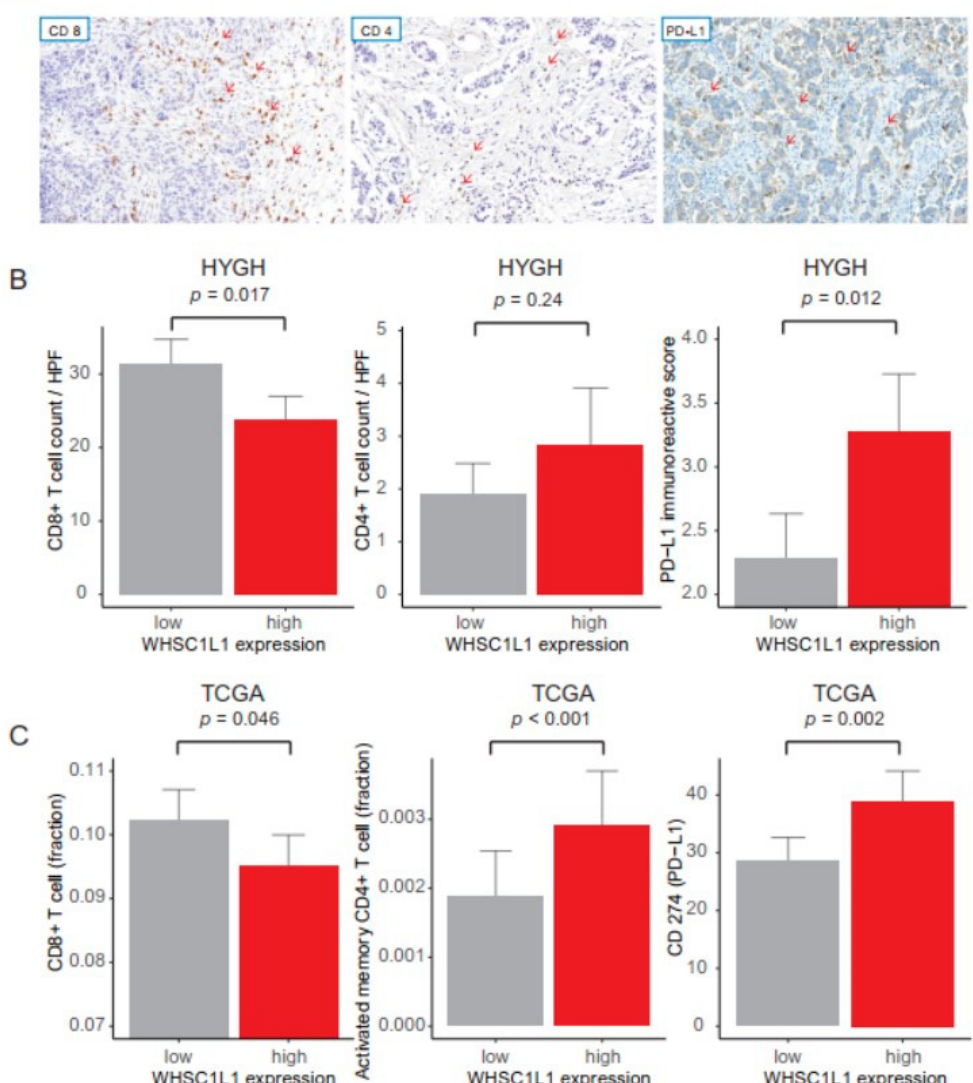
Figure 2. ( A ) Representative microphotographs showing CD8+ T cells, CD4+ T cells and PD-L1 expression from HYGH cohort (red arrows, positive stain (brown color)). ( B ) Bar plot of CD8+ T cell count, CD4+ T cell count per high-power field (HPF, × 400) and PD-L1 expression in HYGH cells. ( C ) Bar plot of CD8+ T cell fraction, activated memory CD4+ T cell fraction and CD274 (encoding PD-L1) expression in